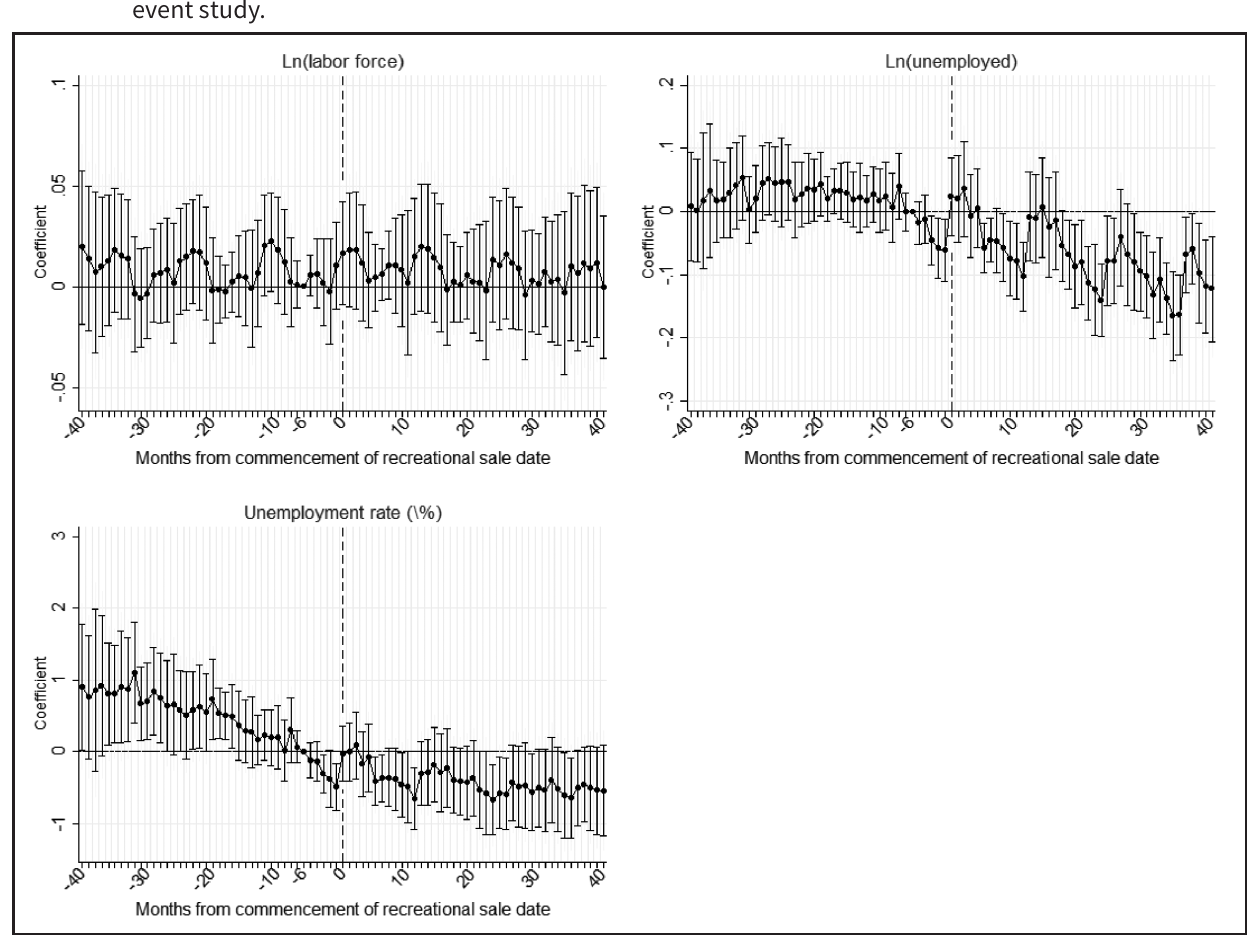
Effect of recreational cannabis entry on the unemployment rate, Ln(labor force) and Ln(unemployed) – event